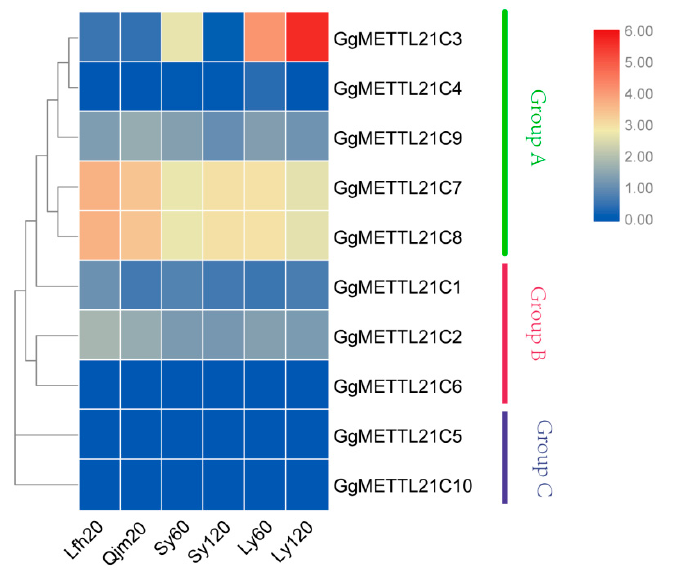
Figure 4. Expression patterns in METTL21C of G. gallus. The heat map was drawn in log10-transformed expression values. Red and blue represent relatively high and low expression, respectively, compared to the control. Lfh represents the chicken of Liangfenghua; Qjm represents the chicken of Qingjiaoma; Sy represents the chicken of Siyu; Ly represents the chicken of Lueyang. The numbers represent the age of the chickens in days.